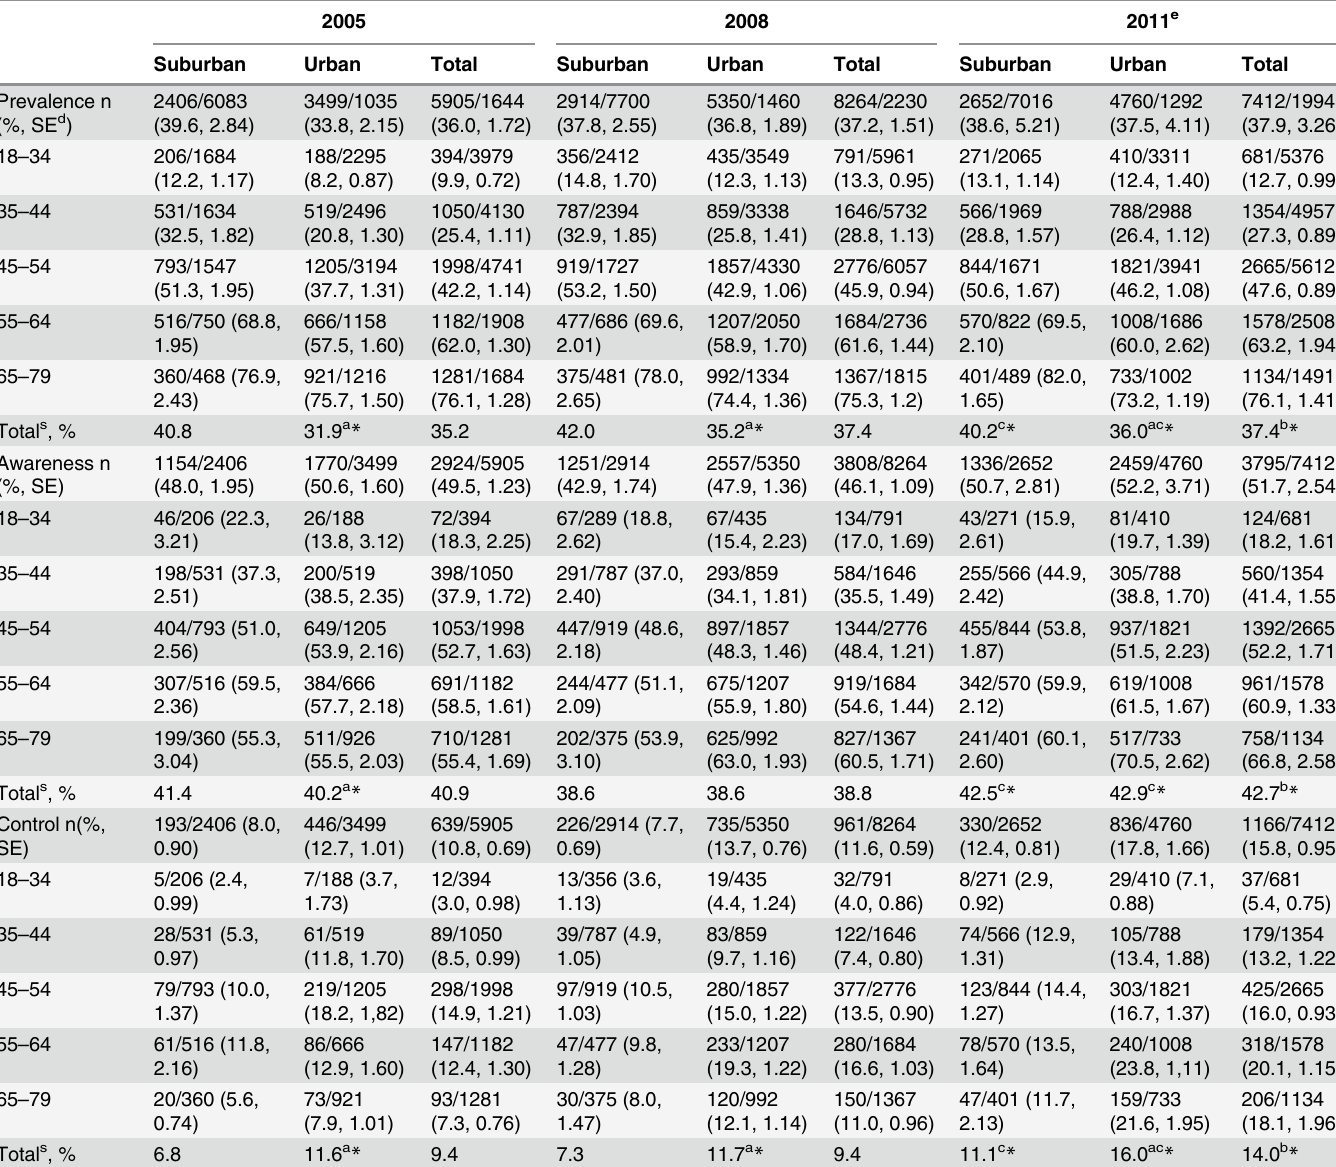
Table 2. Prevalence, awareness, and control of hypertension among adults in Beijing from 2005 to